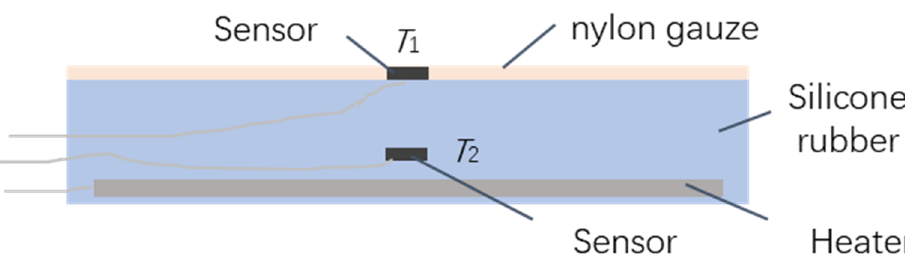
Figure 1. The diagram of ZHF, with the sensor with the silicone rubber and under the heater. The probe is comprised of silicone rubber, with one temperature sensor T 1 installed in the middle of the upper surface, the other temperature sensor T 2 and a heater is embedded inside the rubber. They are all connected to hardware the control the heater output to ensure that the reading of T 1 is equivalent to T 2 over